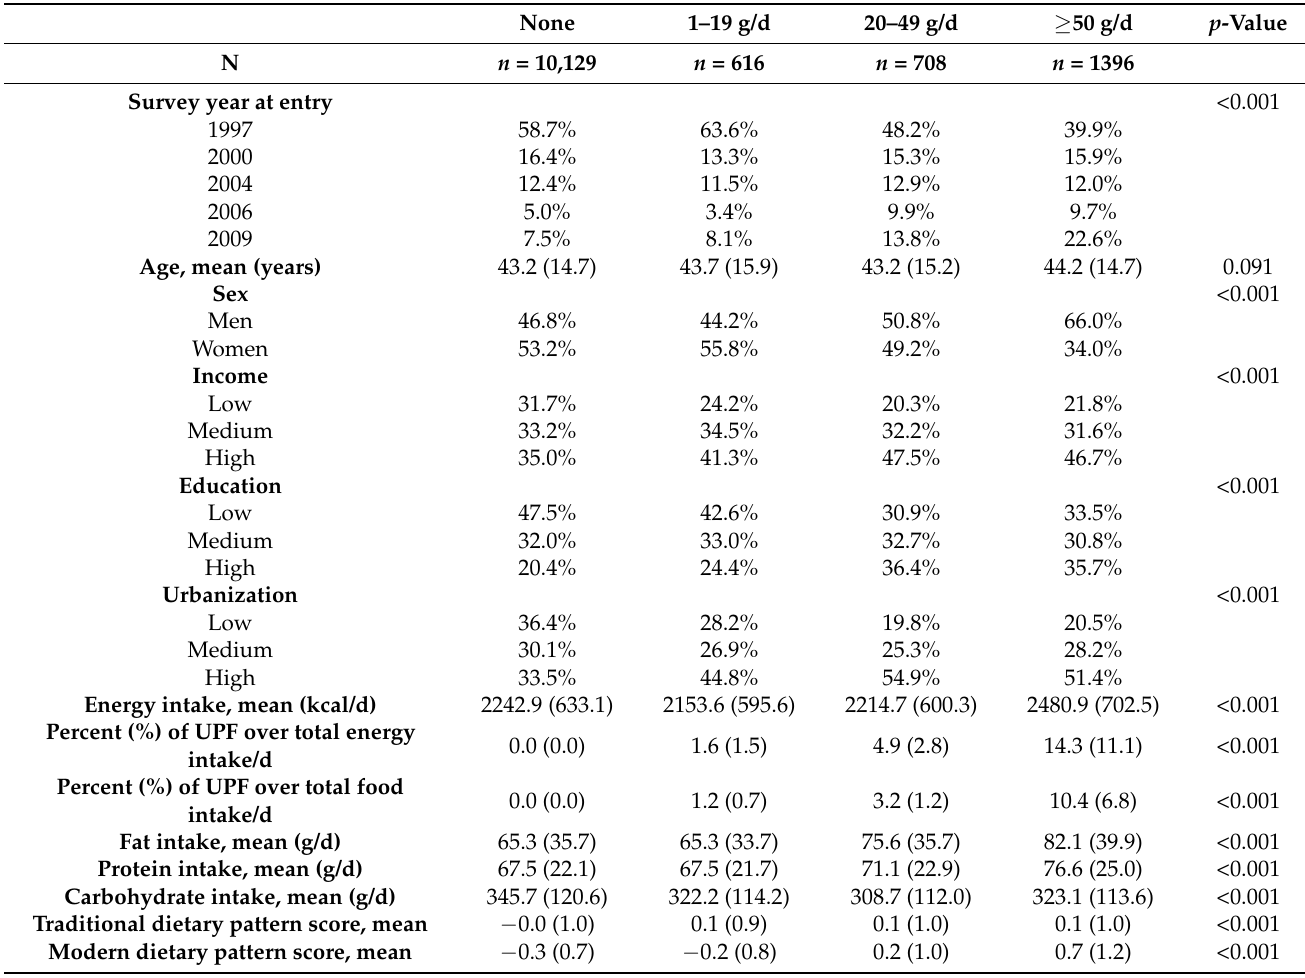
Table 1. Sample characteristics by ultra-processed food intake among participants attending China Health and Nutrition Survey ( n =